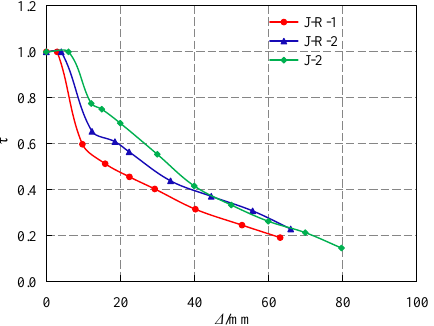
Figure 14. Stiffness reduction curves of specimens.